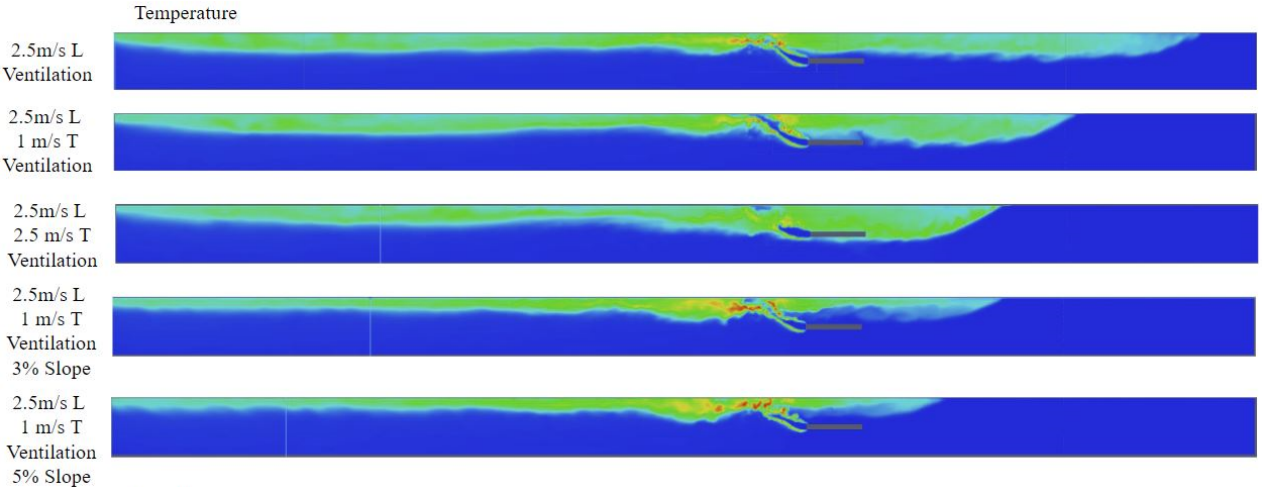
Figure 11. 2D temperature and velocity contour plots at 45 s—the combined effect of the influencing parameters (Cases 2, 10, 11, 12, and 13). The colour code is the same as in Figure 7.